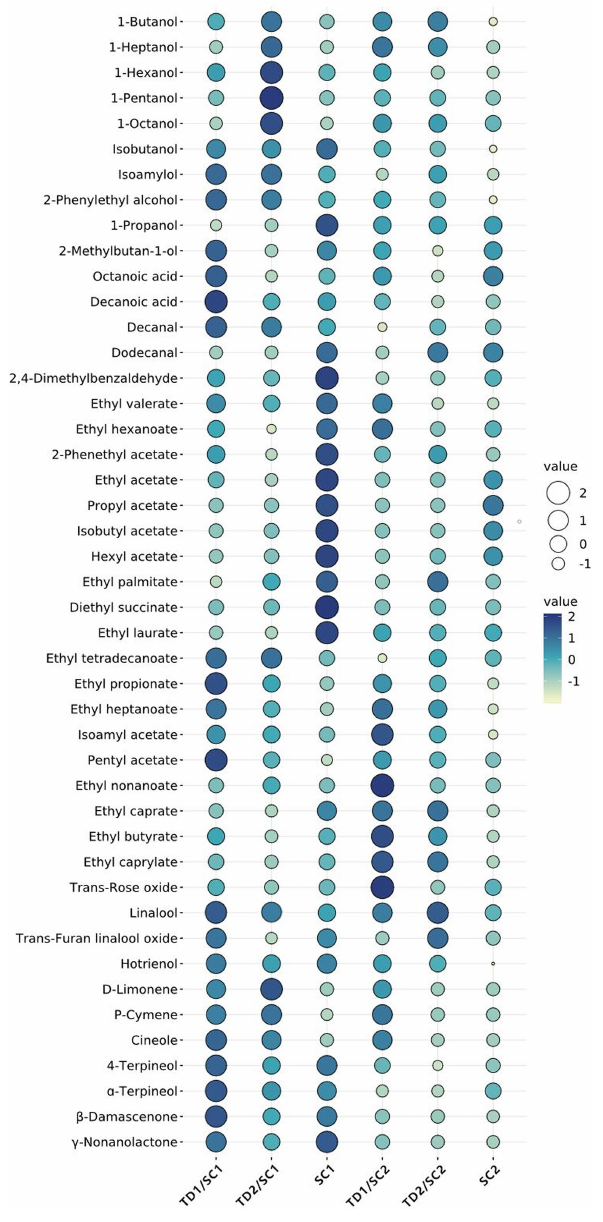
FIGURE 2 | Bubble chart of major aroma compounds in pure and mixed fermented icewines. Size and color of bubble represent the relative abundance of major aroma compounds; the larger the size, the darker the color, the greater the relative abundance of aroma compound. TD1/SC1, TD2/SC1, TD1/SC2, TD2/SC2: sequential inoculation with T. delbrueckii (TD1, TD2) followed by S. cerevisiae (SC1, SC2) after 48 h; SC1 and SC2: single inoculation of S. cerevisiae SC1 and SC2,